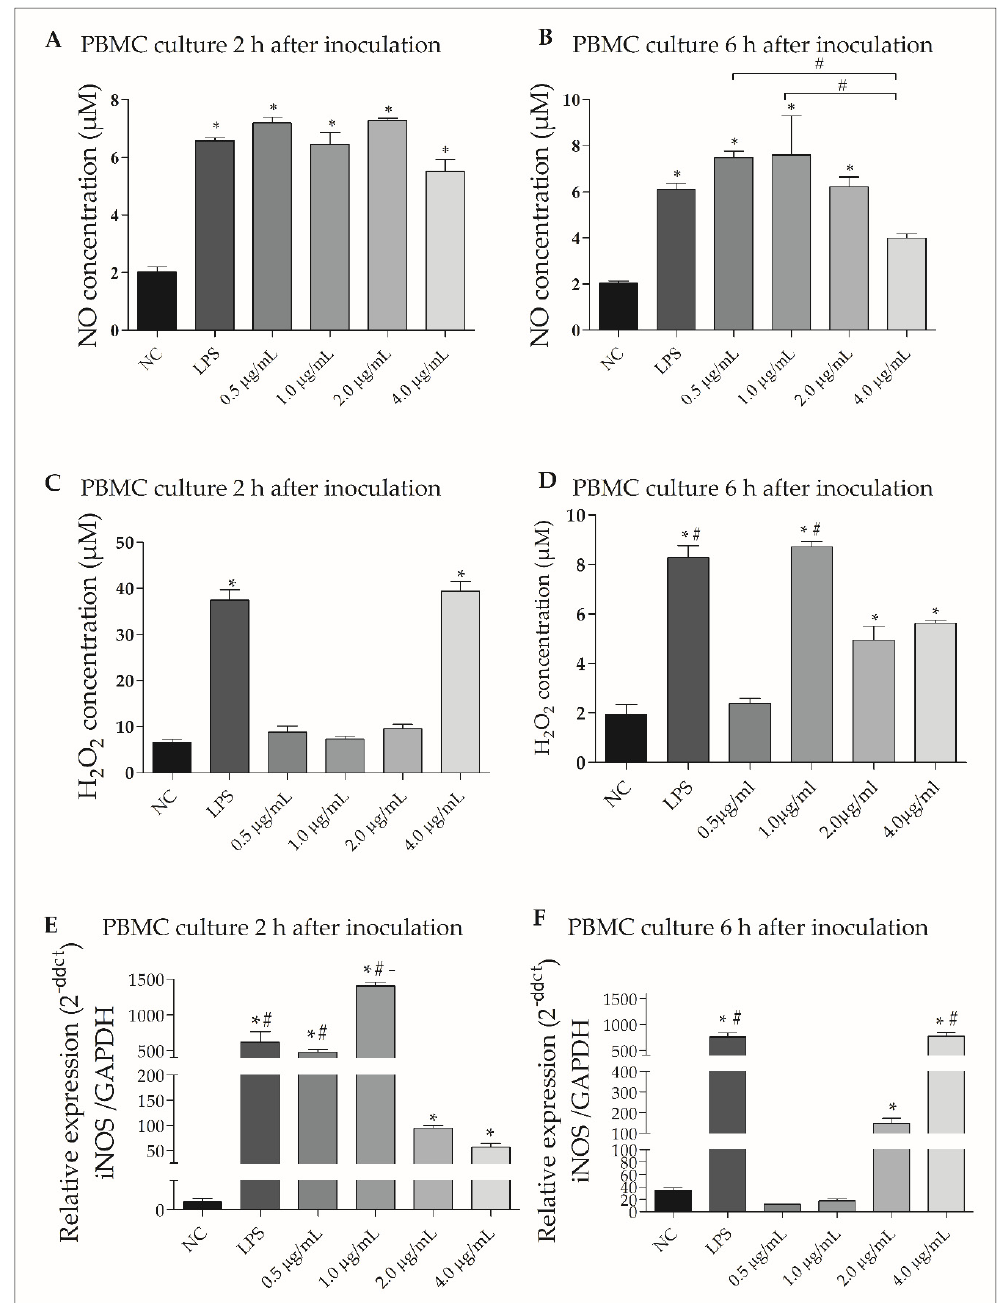
Figure 4. NO and H 2 O 2 concentrations and inducible nitric oxide synthase (iNOS) expression in bovine peripheral blood mononuclear cell (PBMC) culture supernatant after incubation with 0.5, 1.0, 2.0, and 4.0 μ g/mL recombinant GUDIV-103 (rGUDIV-103) lipoprotein for ( A , C , E ) 2 and ( B , D , F ) 6 h. ( A , B ) NO concentration. ( C , D ) H 2 O 2 concentration. ( E , F ) iNOS gene expression. NC: negative control (50 μ L phosphate-buffered saline, pH 7.4), positive control: LPS (lipopolysaccharide) (100 ng/mL). Relative iNOS expression compared with that of glyceraldehyde-3-phosphate dehydrogenase (GAPDH). Treatments were compared using the Kruskal – Wallis non-parametric test followed by Dunn’s post hoc test. Different symbols indicate statistically different groups. Statistical significance ( p < 0.05) is represented by the symbols ( ∗ , #, -). Data are expressed as the mean ± standard deviation (n = 9). * p < 0.05 vs. negative group. # p < 0.05 vs. LPS group. - p < 0.05 vs. 0.5 µ g/mL